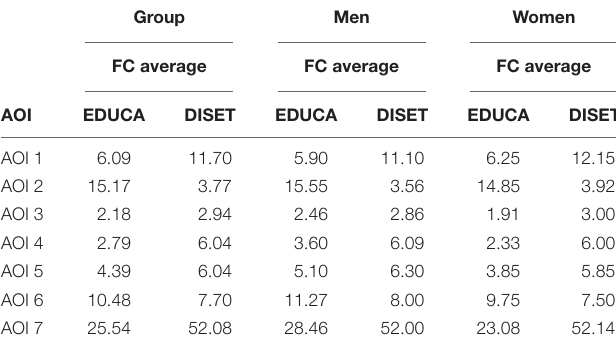
TABLE 6 | Fixation Count (FC) of the total of participants to each AOI. Group Men